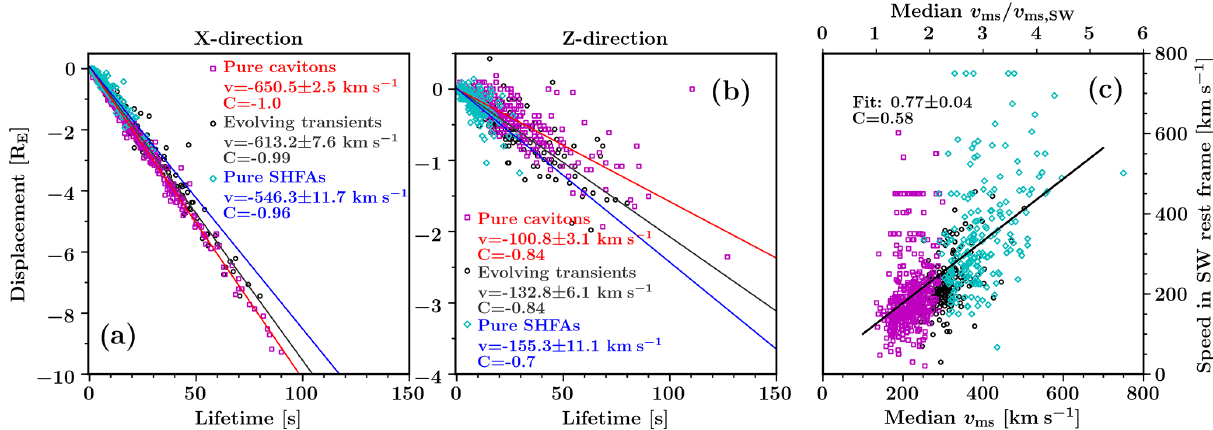
Figure 8. (a, b) Scatterplots of the lifetimes of the transients against their displacements in the x direction and the z direction. Linear fits in each panel estimate the propagation velocities for different transient types, including the standard error of the slope of the fit and the Pearson correlation coefficient C . (c) Scatterplot of the over-lifetime median magnetosonic speeds v ms inside the transients against the solar wind rest frame propagation speeds of the